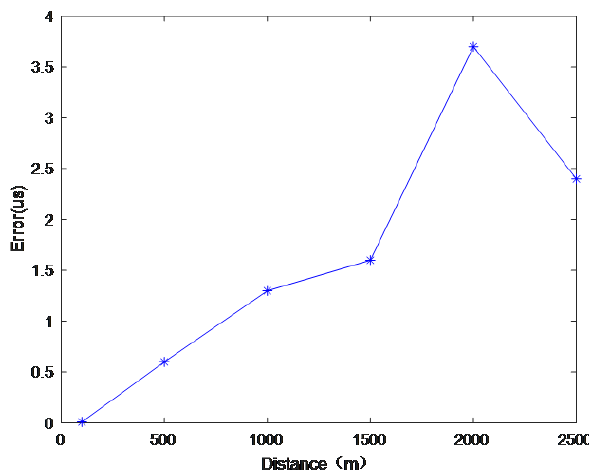
Figure 7. Shows the error of multipath delay calculation at different distances.